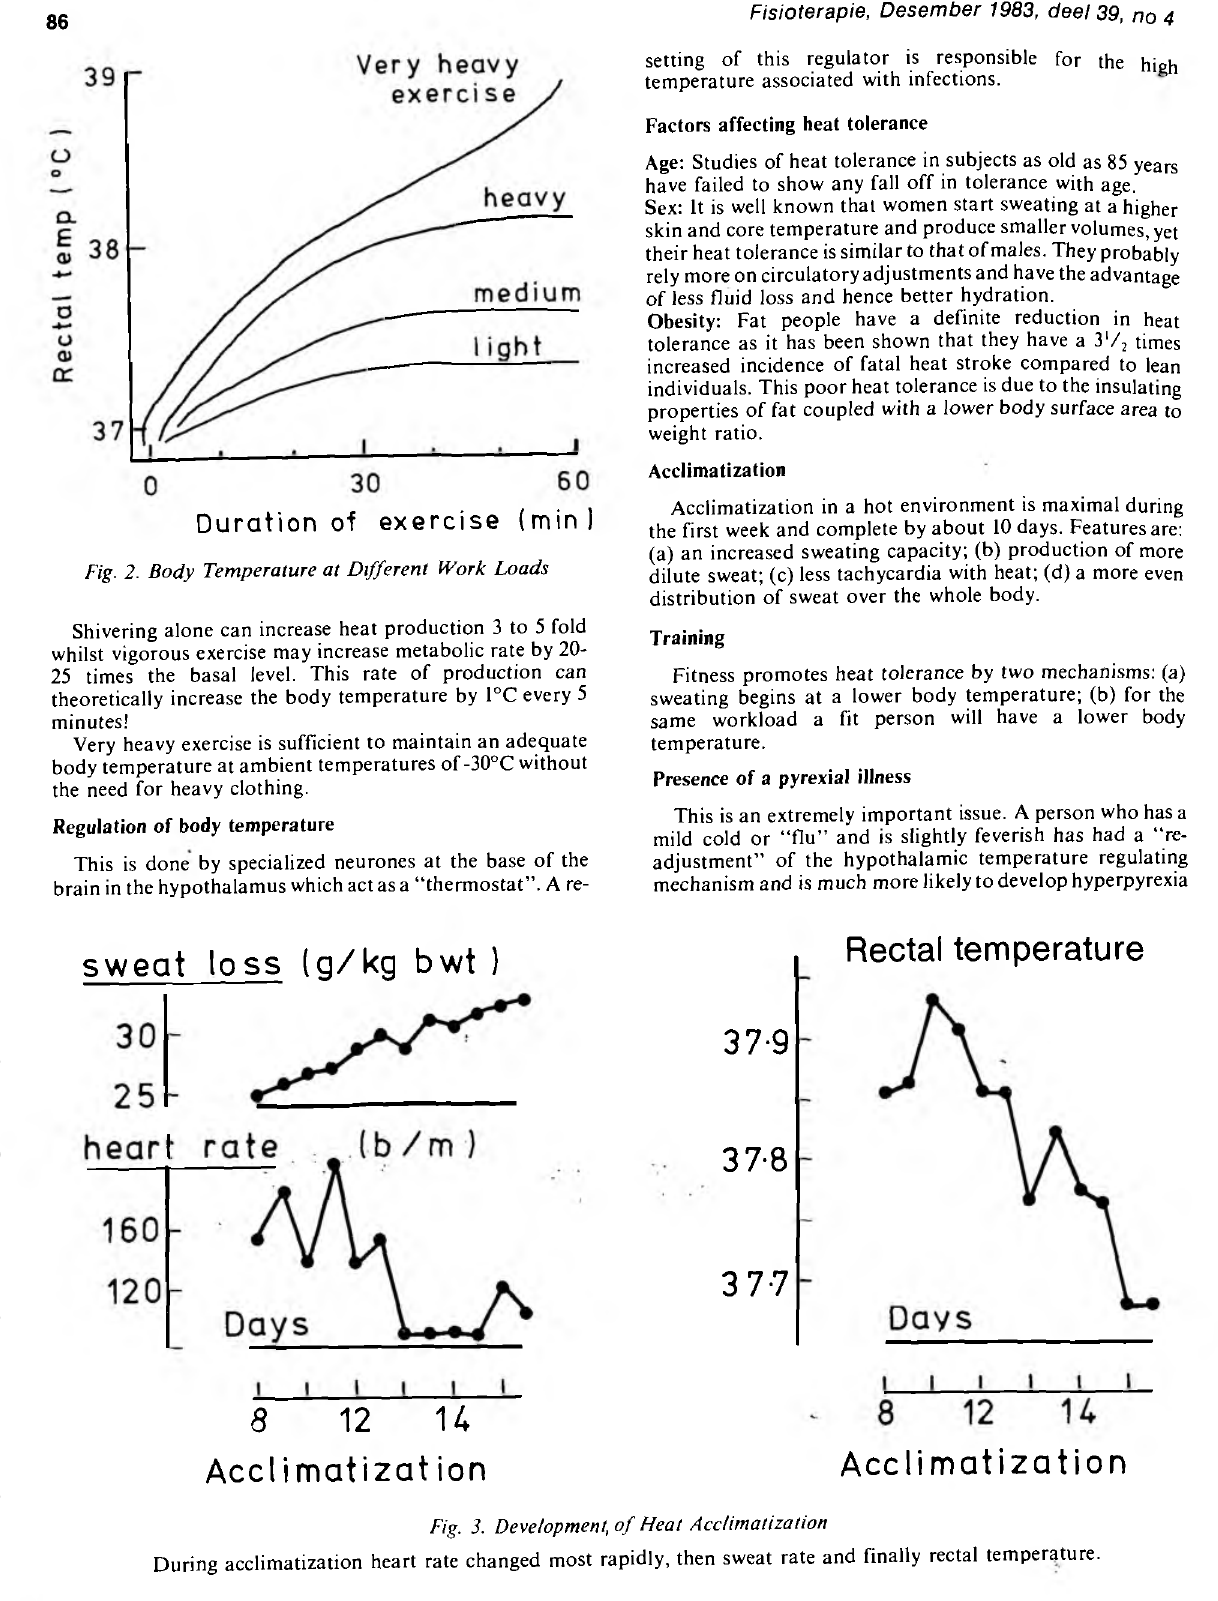
Fig. 3. Development, of Heat